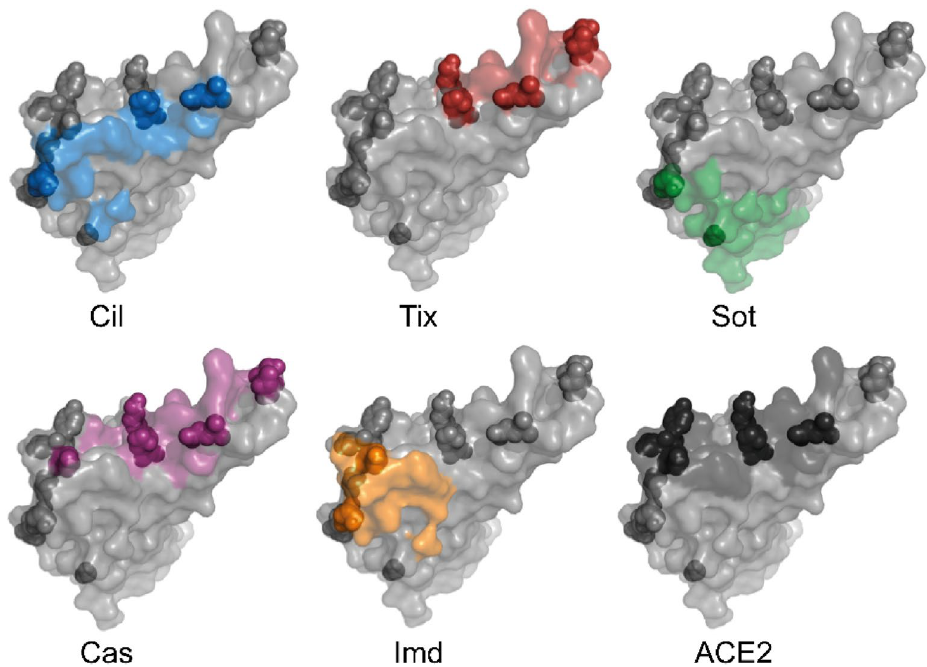
Figure 2. Omicron BA.1 spike mutations compared to antibody epitopes and the ACE2 binding motif. RBD is shown as grey surface with residues within 5 Å of indicated interacting partner colored and Omicron BA.1 mutations shown as spheres. PDB codes for structures are: 7L7E 25 (cilgavimab and tixagevimab), 7SOC 26 (sotrovimab), 6XDG 23 (casirivimab and imdevimab), and 7DQA 27